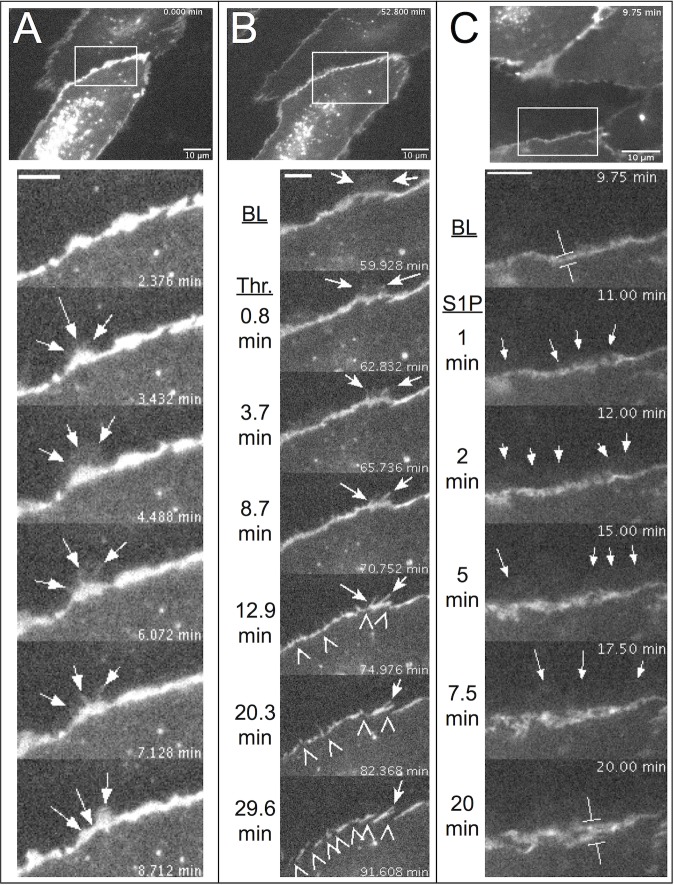
Local lamellipodia protruded beyond endothelial adherens junctions containing VE-cadherin-GFP and were associated with junction stability.At the top of all three panels, an image of HUVEC expressing VE-cadherin-GFP is shown. The bounding box in each top image shows the area studied in the time-lapse montages below. Confluent monolayers were used for all experiments, but not all cells expressed detectable levels of VE-cadherin-GFP. A. Time-lapse imaging revealed that VE-cadherin-GFP was most intense at intercellular junctions and in vesicles around the nucleus. Select time-lapse images (from S6 Movie) of the area in the box from top panel show the protrusion and withdrawal of a local lamellipodium (arrows) that spread toward the cell in the top of the image from the belt of VE-cadherin-GFP located between two cells. B. The same cells were tracked just before and during 1 U/ml thrombin treatment. Selected time-lapse images from the bounding box in the top panel (from S7 Movie) show how the withdrawal of a local lamellipodium that had protruded prior to thrombin treatment yielded filopodia-like structures containing VE-cadherin (arrows). Subsequently, as fewer lamellipodia protruded from the cell edge, breaks in the continuous belt of VE-cadherin emerged (arrowheads). C. Time-lapse studies before and after treatment with 2 μM S1P (from S8 Movie) show that lamellipodia spread beyond the VE-cadherin-GFP-rich junctions (arrows). In addition, over time the junctional areas containing VE-cadherin-GFP appeared wider than during baseline (compare the calipers at BL and 20 min). Images are representative of observations from at least three different experiments each with thrombin and S1P.